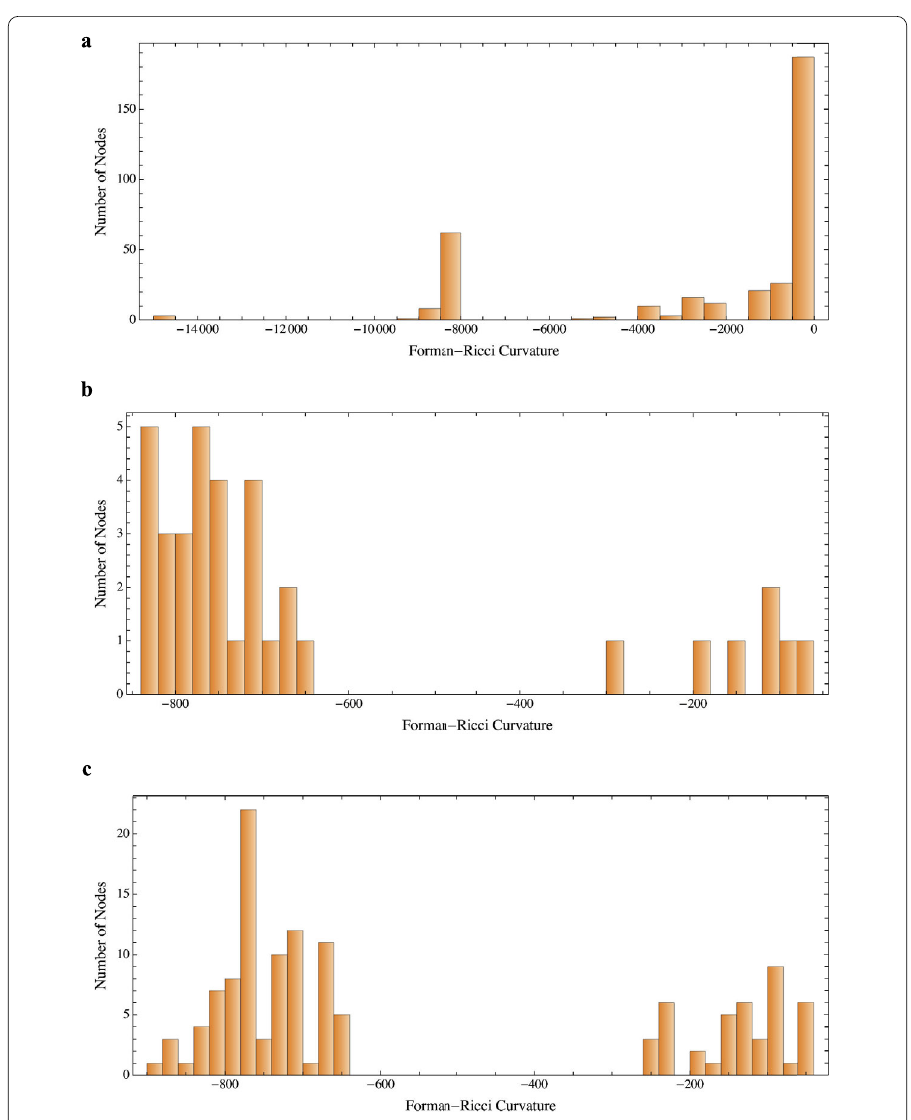
Figure 7 Forman–Ricci Curvature Histograms for Embedded Cliques in the Bahamas and the Panama Networks. The figures show histograms for the values of the Ricci–Forman curvature corresponding to the edges of the reduced k -cliques as they appear when viewed (embedded) inside the original network: ( a ) Values for the edges of all 6-cliques in Bahamas Leaks. ( b ) Values for the edges of all 6-cliques in Panama Papers. ( c ) Values for the edges of all 5-cliques in Panama